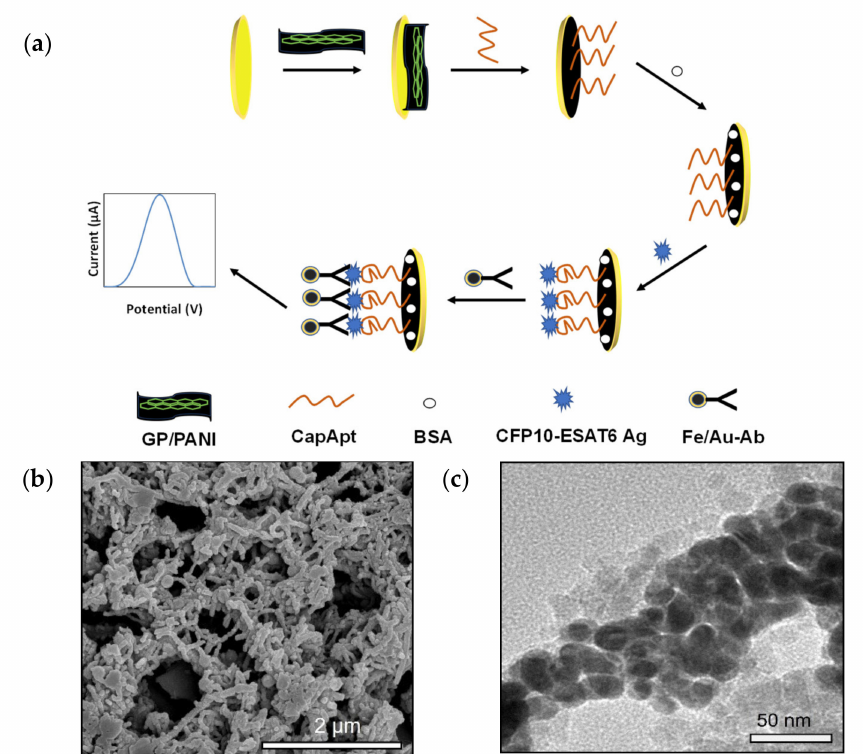
Figure 3. ( a ) Schematic flow of the electrochemical aptamer-based assay showing (i) modifica- tion of SPGE surface with GP/PANI, (ii) CapApt immobilization on GP/PANI-modified screen- printed gold electrode (SPGE), (iii) blocking by bovine serum albumin (BSA) to prevent non-specific binding, (iv) CFP10-ESAT6 antigen immobilization on CapApt/GP/PANI/SPGE surface, and (v) Fe 3 O 4 /Au-Ab immobilization on CFP10-ESAT6/CapApt/GP/PANI/SPGE surface. ( b ) GP/PANI nanocomposite structure and ( c ) Fe 3 O 4 /Au MNPs